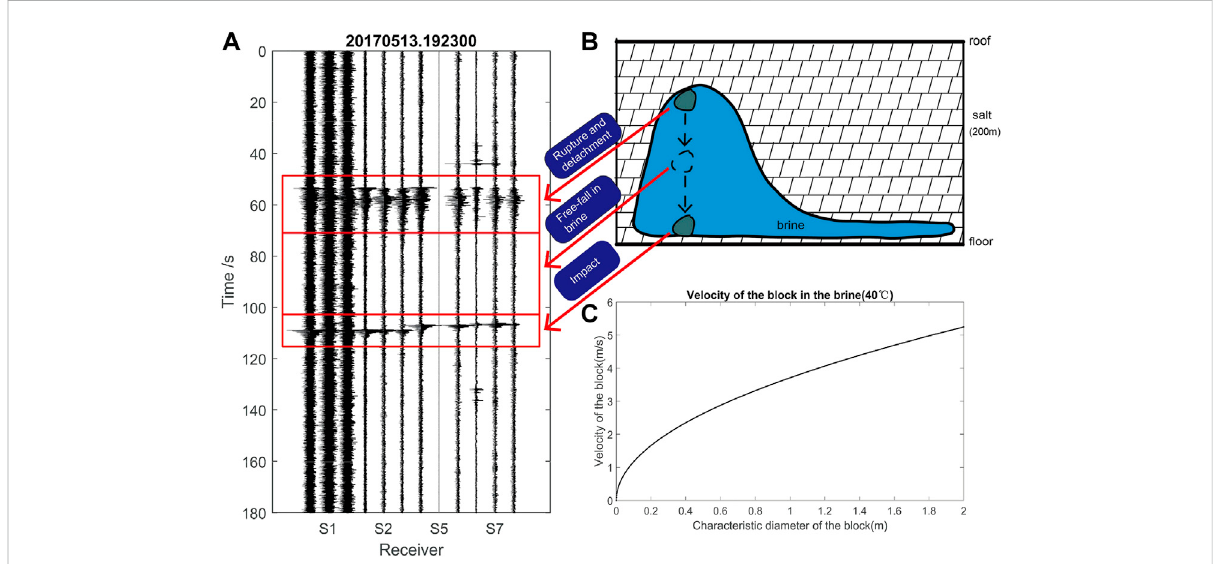
FIGURE 9 Cartoon showingthemechanism oftheobservedpairedsignalsfor solutionsaltmining. (A) Thepairedsignalsobservedatdifferentstations. (B) The cartoon showing the physical process producing paired signals. (C) The velocity of the falling bock from the roof through the brine estimated using Eq.